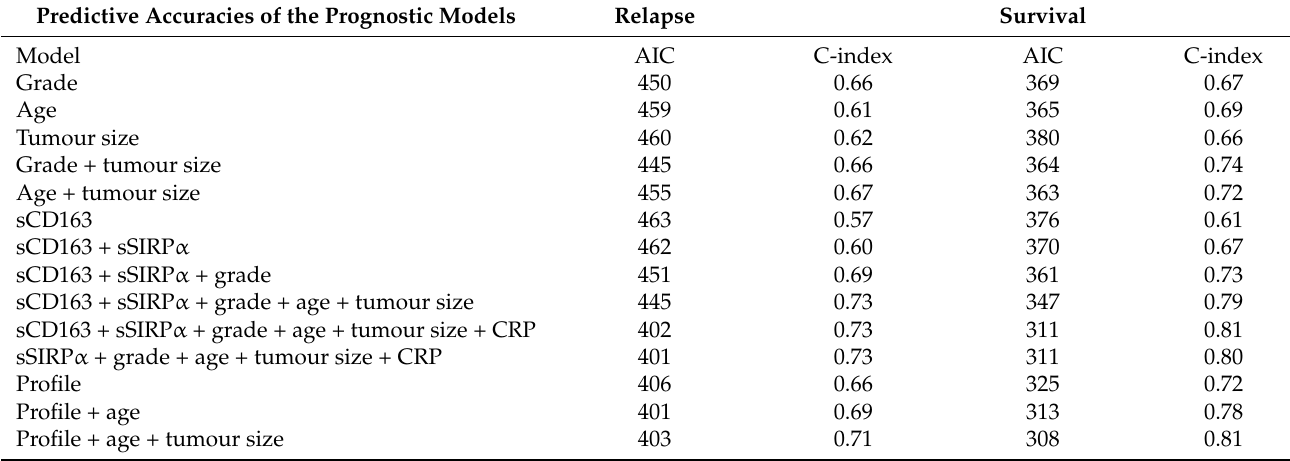
Table 3. The AIC and concordance indexes for the different prognostic